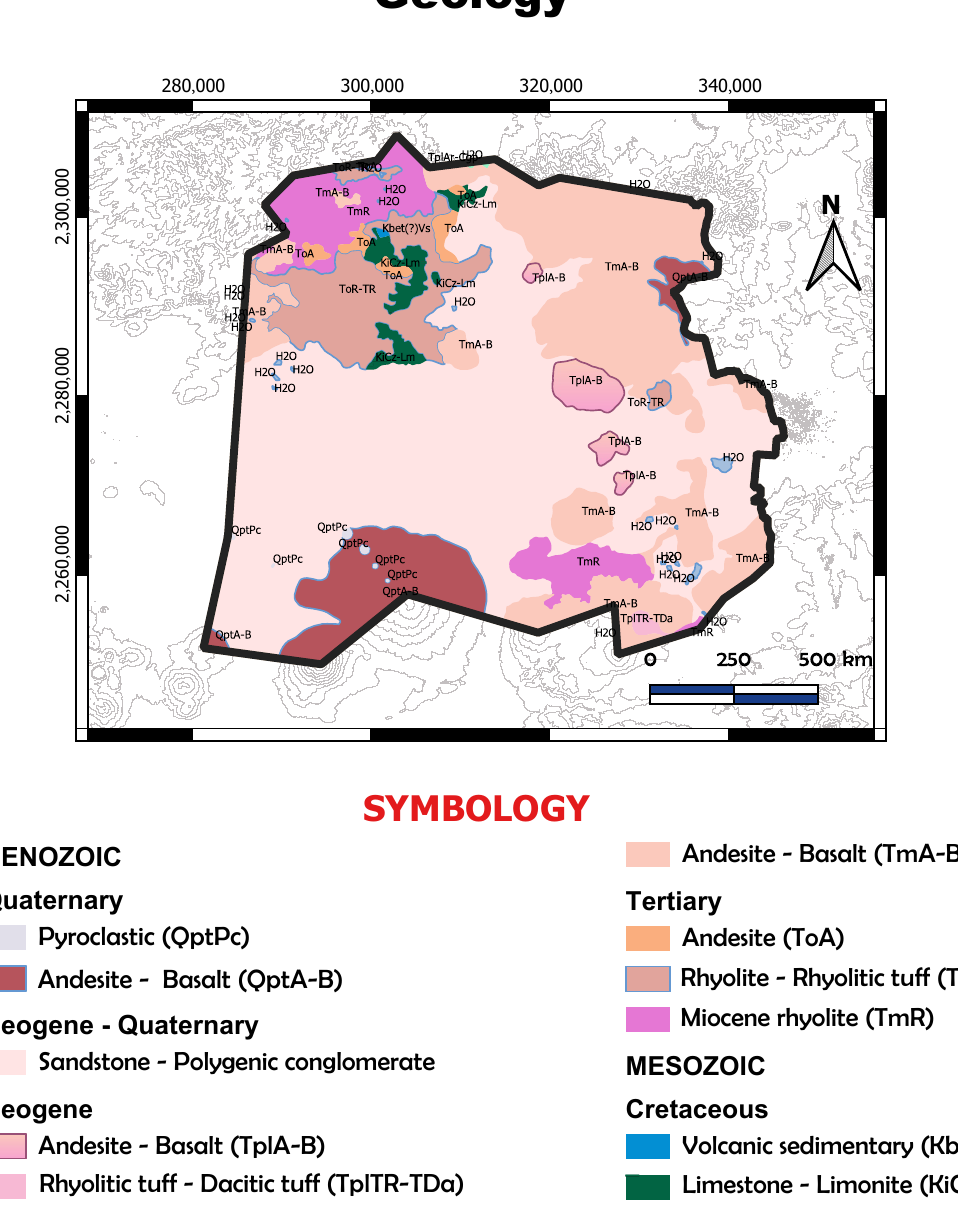
Figure 2. Geology map of the CV aquifer. Coordinate system: WGS 84/UTM Zone 14 Figura 1.8: Mapa Geol´ogico del Valle de Celaya